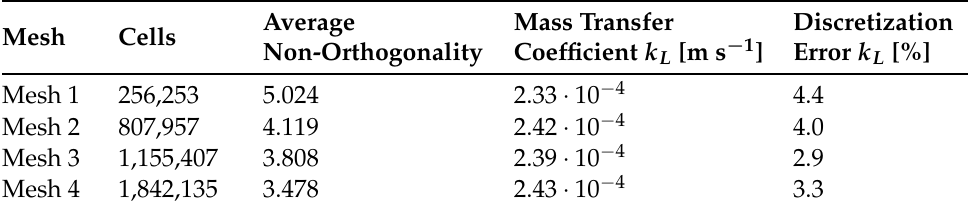
Table 3. Discretisation error calculated by the Richardson extrapolation for the mass transfer coefficient k L